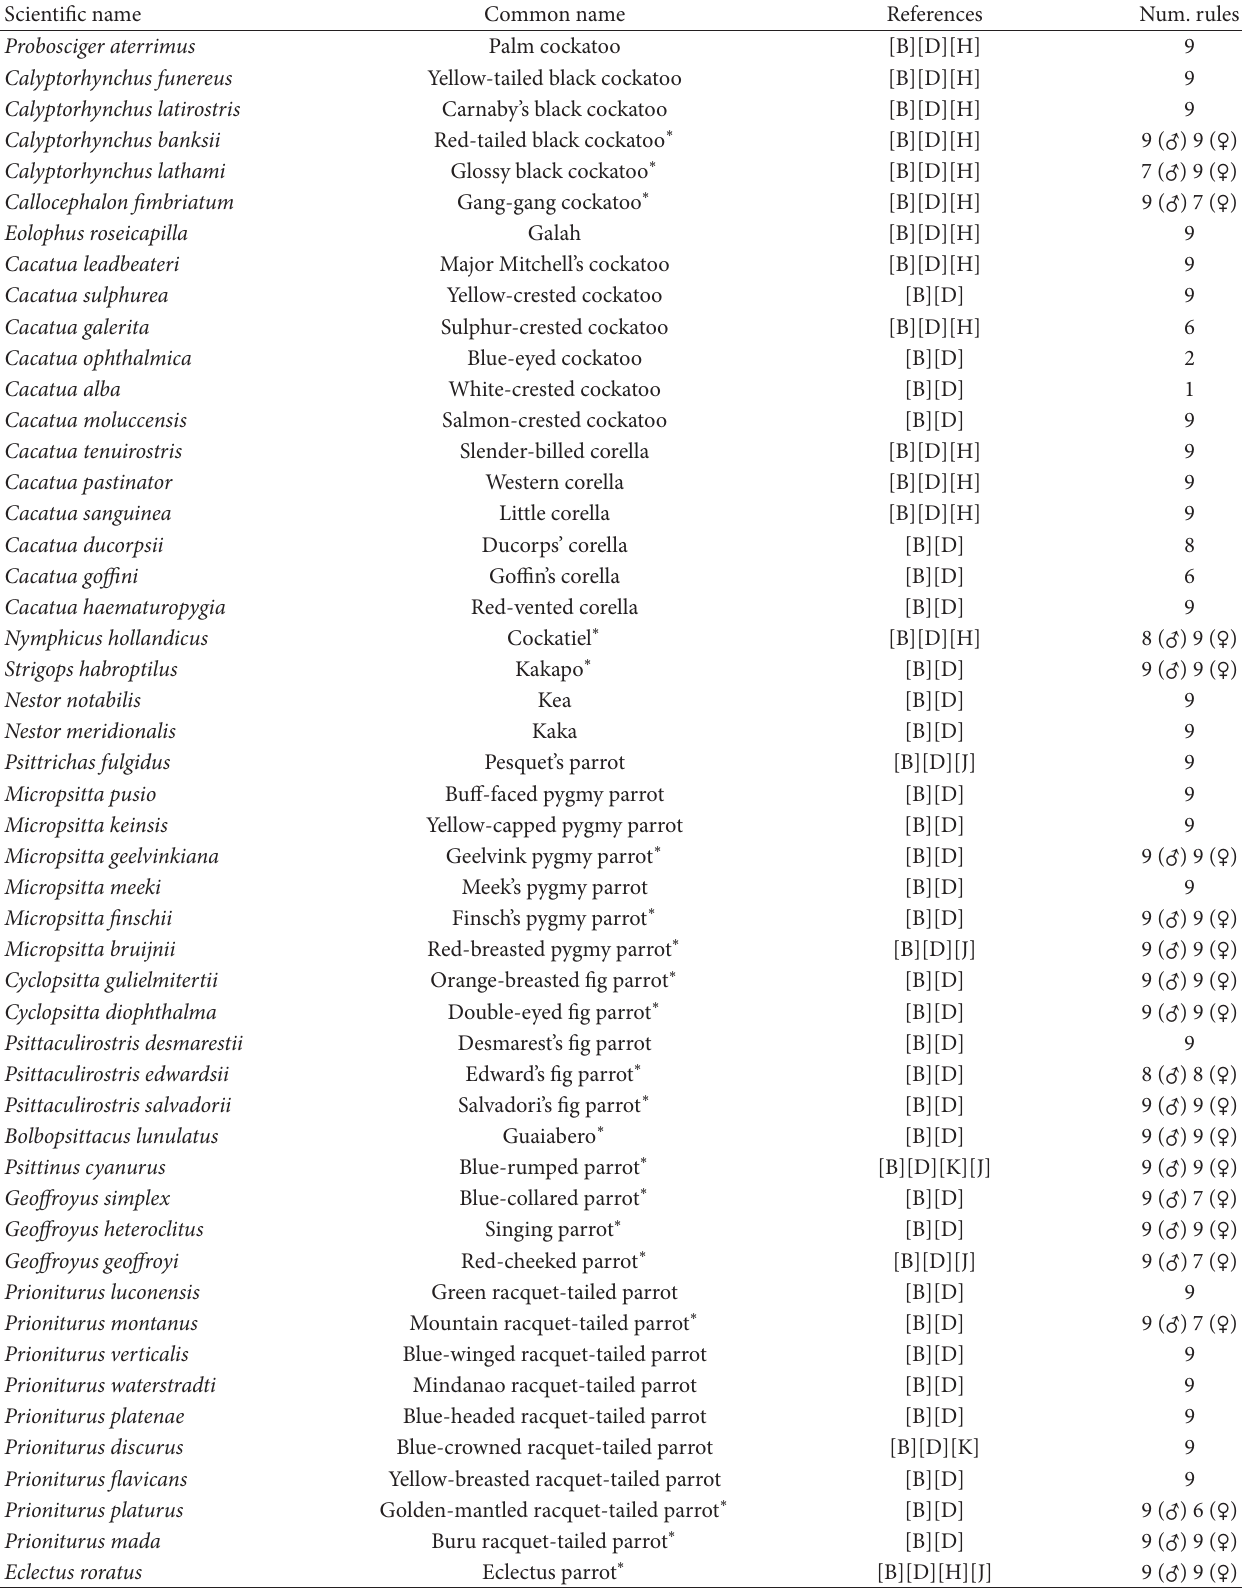
Table 5: Included genera and